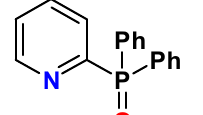
Figure 13. P,P-diphenyl pyridine-2-phosphine oxide PyPO .